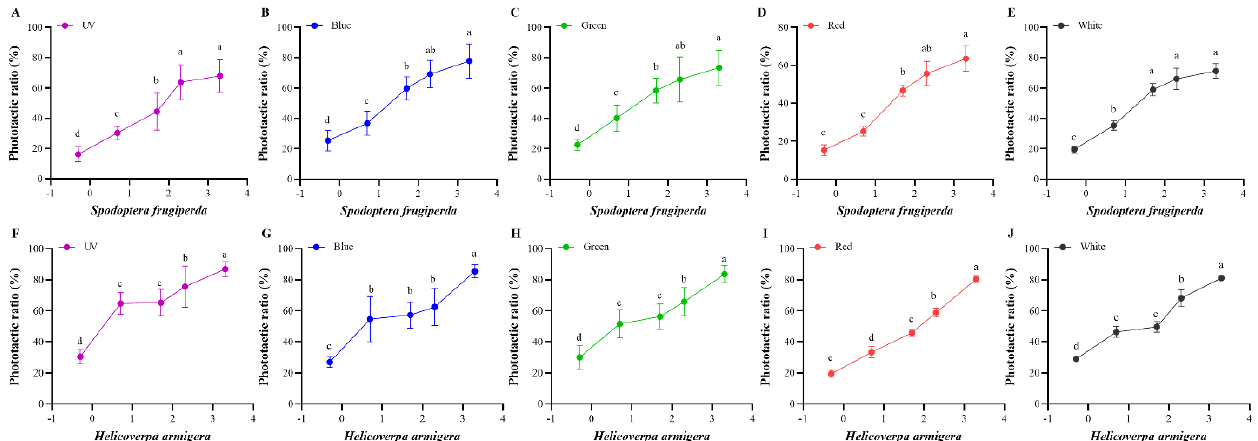
Figure 2. Phototactic rates of male and female adults of S. frugiperda and H. armigera . ( A – E ), photo- tactic ratios of male and female adults of S. frugiperda to different wavelength lights under five light intensities (( A ) for UV light; ( B ) for blue light; ( C ) for green light; ( D ) for red light; ( E ) for white light). ( F – J ), phototactic ratios of male and female adults of H. armigera to different wavelength lights under five light intensities (( F ) for UV light; ( G ) for blue light; ( H ) for green light; ( I ) for red light; ( J ) for white light). Data are mean ± SE. Means between the two groups under the same light intensity were compared according to Student’s t -test ( p < 0.05). UV, UV LED; Blue, blue LED; Green, green LED; Red, red LED; White, white LED.